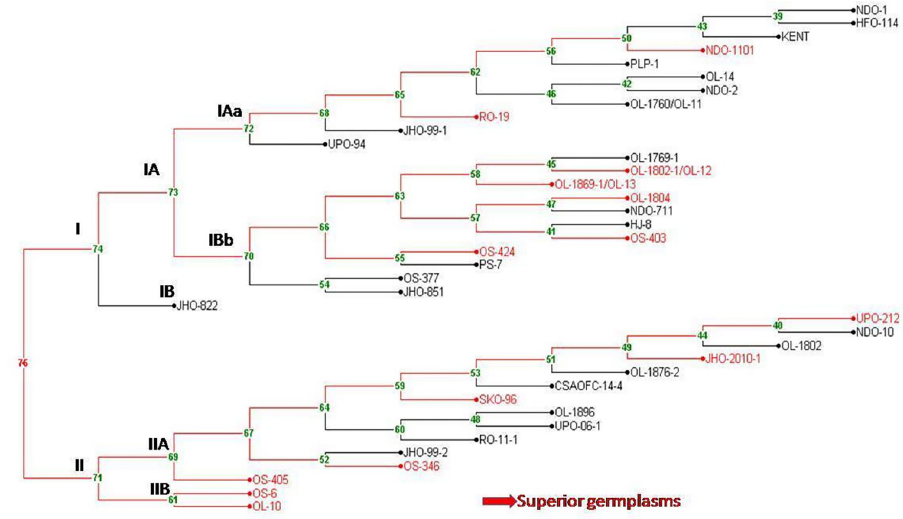
Fig 2. Dendrogram of 38 Avena sativa L . based on 22 Inter Simple Sequence Repeats (ISSRs) markers.